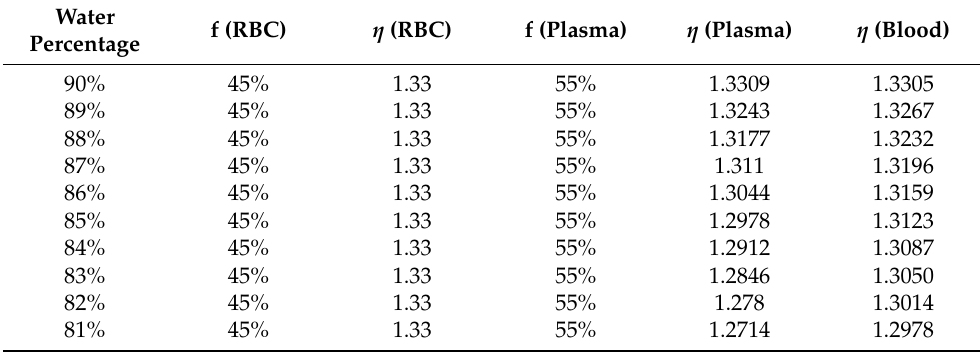
Table 4. Variation of the refractive index of blood with water